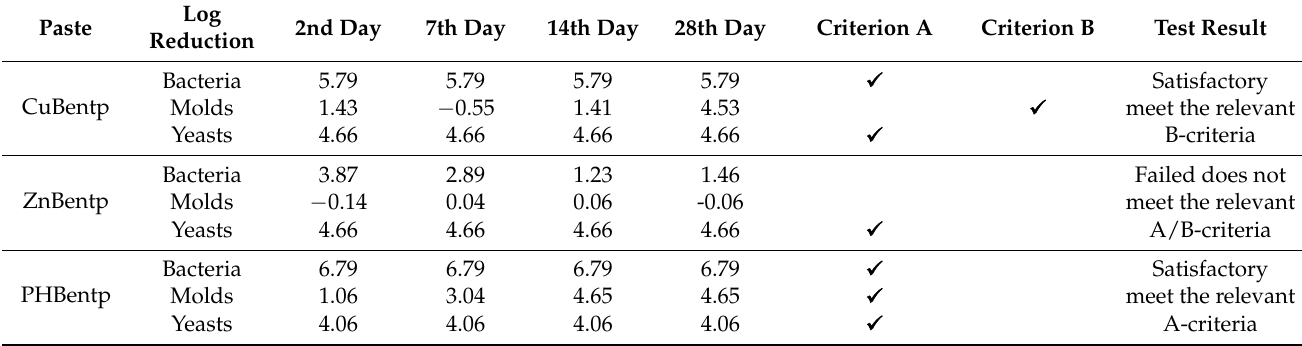
Table 7. Criteria of acceptance. (Evaluation Criteria).